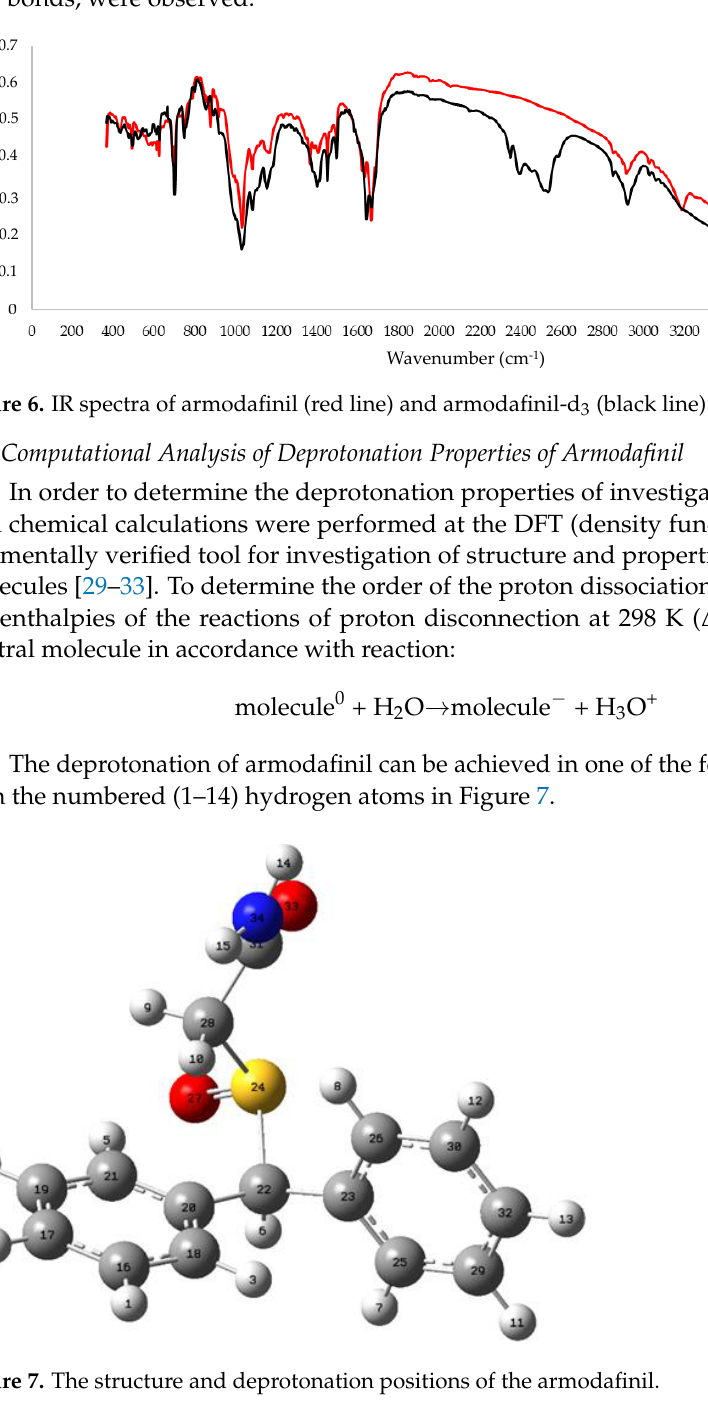
Table 1. The H 298 (in hartree) of armodafinil anions and ∆H 298 of deprotonation reaction (kcal/mol). The most energetically effective deprotonation position is marked with red font.